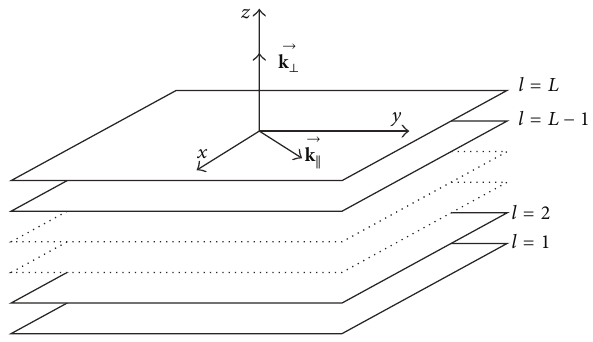
Figure 1: The planar model of thin film: the film can be treated as a set of 𝐿 crystallographic planes (layers) parallel to the surface. The wave vector is decomposed into two components, k ‖ = (𝑘 𝑥 , 𝑘 𝑦 ) and k ⊥ , parallel and perpendicular to the surface,